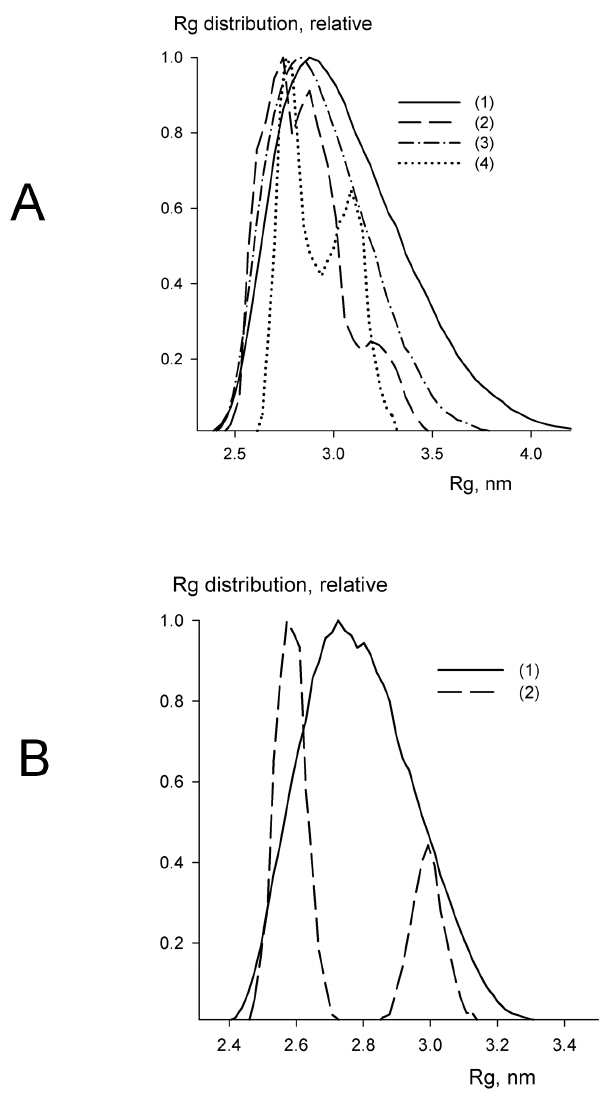
Figure 3. R g distributions from EOM for M.SsoII. Solid and dashed-dot lines (curves 1 and 3) correspond to initial random pool; dashed and dotted lines (curves 2 and 4) to the selected ensembles (average of 50 independent EOM runs). Curves 1–2 correspond to the randomly generated N-terminal region of M.SsoII (‘‘hybrid M.HhaI model’’) and curves 3–4 were obtained with the ‘‘hybrid M.HhaI-P434 model’’. The large width of the selected R g distributions supports the flexibility of the N-terminal region in the M.SsoII molecule ( A ). R g distributions from EOM for the M.SsoII–15met complex. The notations are the same as in (A) for the curves (1–2) ( B